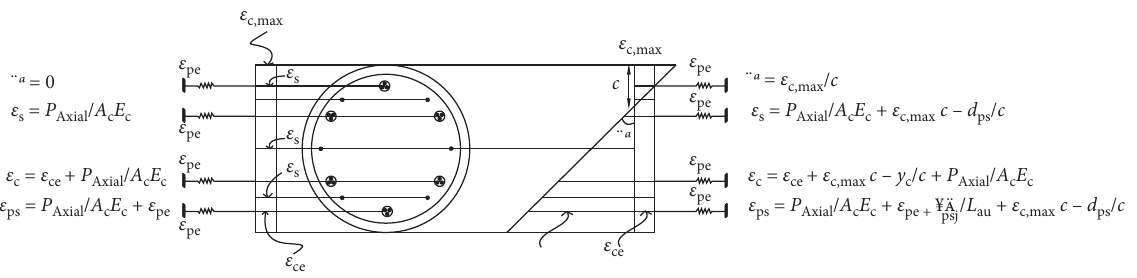
Figure 8: Conceptual diagram of M-Phi